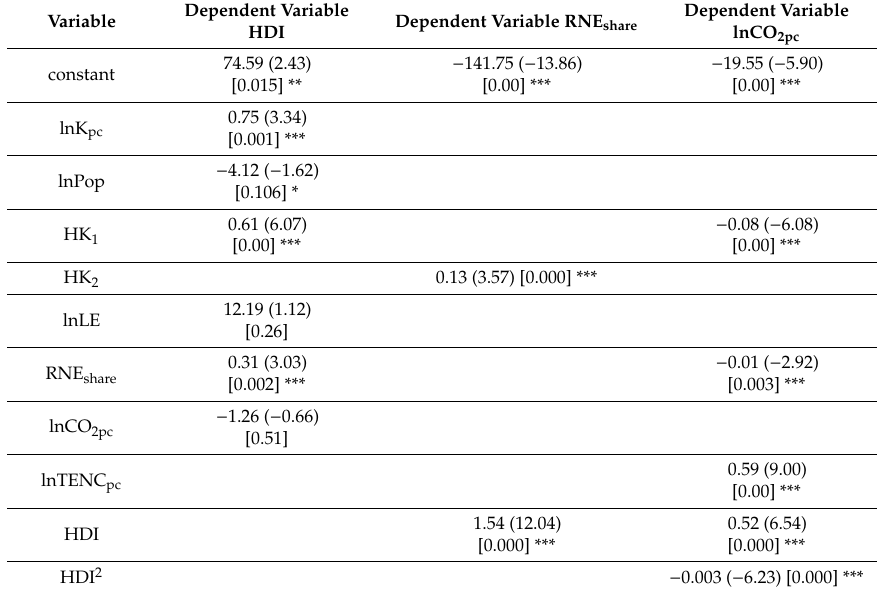
Table 3. The results of the study, 3SLS (three-stage least squares) method, 28 OECD countries,